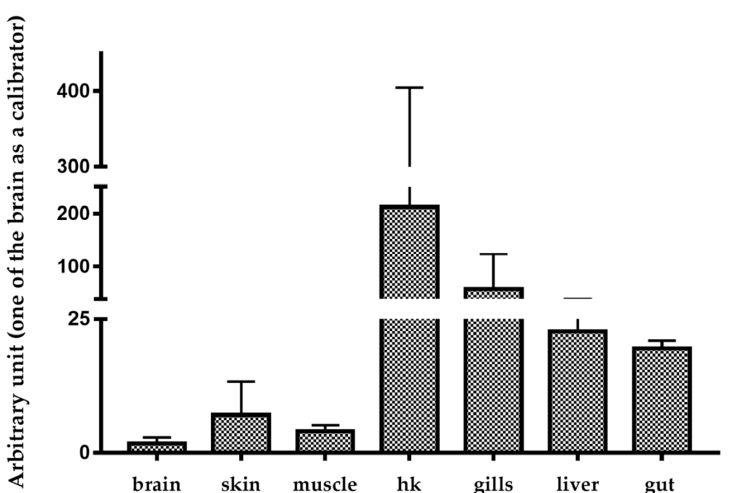
Figure 2. Trematocine basal expression in different tissues. Trematocine mRNA levels were expressed as a ratio to 18 S rRNA levels in the same samples after real-time PCR analysis using the tissue with the lowest expression (brain) as the calibrator.